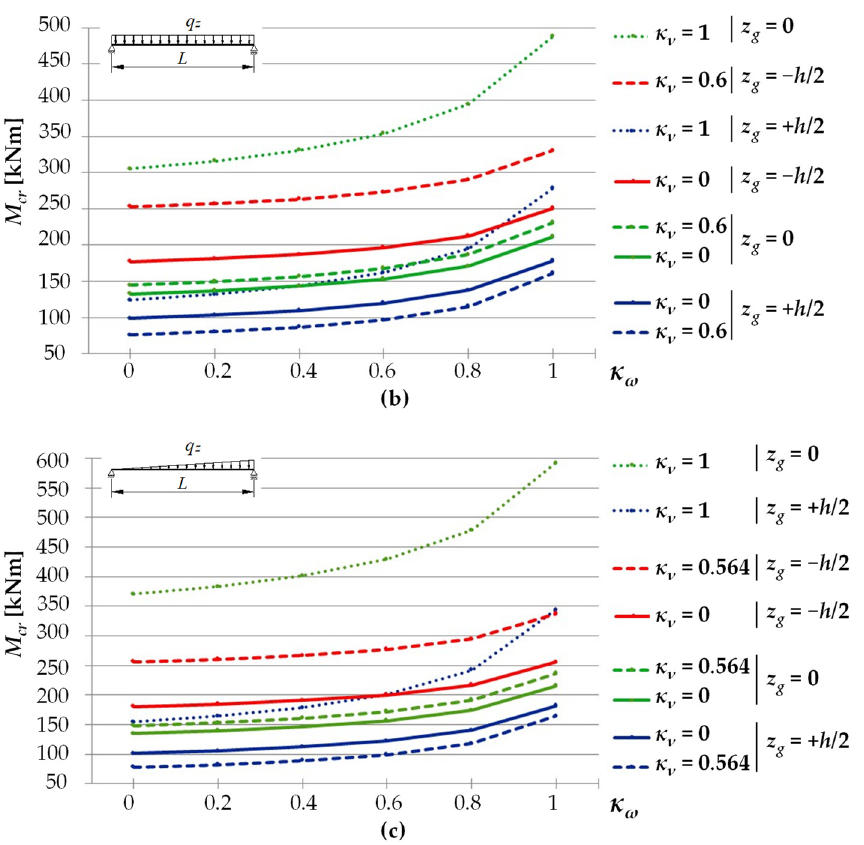
Figure 6. Critical moments of LTB for an IPE300 ( L = 5 m) beam as a function of the κ ω index for selected values of the κ ν index: ( a ) concentrated force load, ( b ) uniform load, ( c ) triangular load. Figure 7 shows a comparison of the variation trends in LTB critical moments M cr of the beam, determined by the LTBeamN program (the solid line) and calculated with Equation (13) (the broken line), depending on the index of fixity against rotation in the beam bending plane κ ν (from 0 to 1), for the index of fixity against warping κ ω = 0.6 and the ordinate of the applied load z g = + h /2.